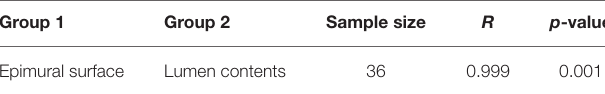
TABLE 2 | Pairwise ANOSIM of weighted UniFrac distance matrix. Group 1 Group 2 Sample size